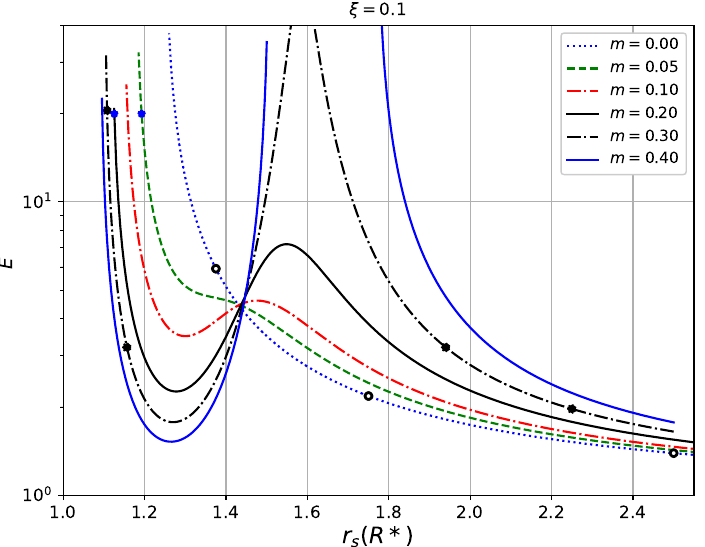
Figure 3. E − r s parameter space for various values of m = 0.0,0.05,0.1,0.2,0.3 and 0.4 keeping ξ = 0.1. Deviation from monotonous trajectory for m = 0 marks effect of cocoon’s collimation on the jet dynamics. For m ≥ 0.1, in certain range of E , we obtain three sonic points for single value of E , it marks possibility of shock transition in the flow. Points with black open circles and filled blue stars show the location of sonic points corresponding to solutions in Figure 4 top-left panel and bottom-right panel, respectively. Solutions corresponding to sonic points with filled black circles on case m = 0.3 are shown in Figure